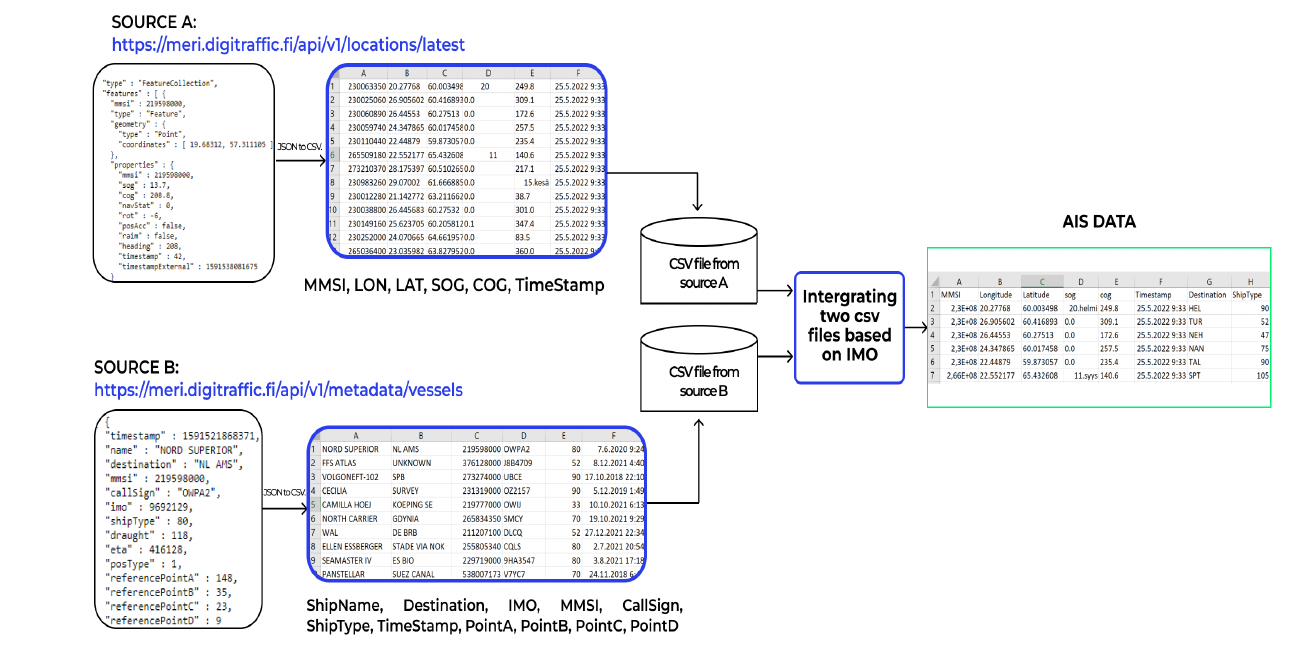
Figure 11. The process of AIS message